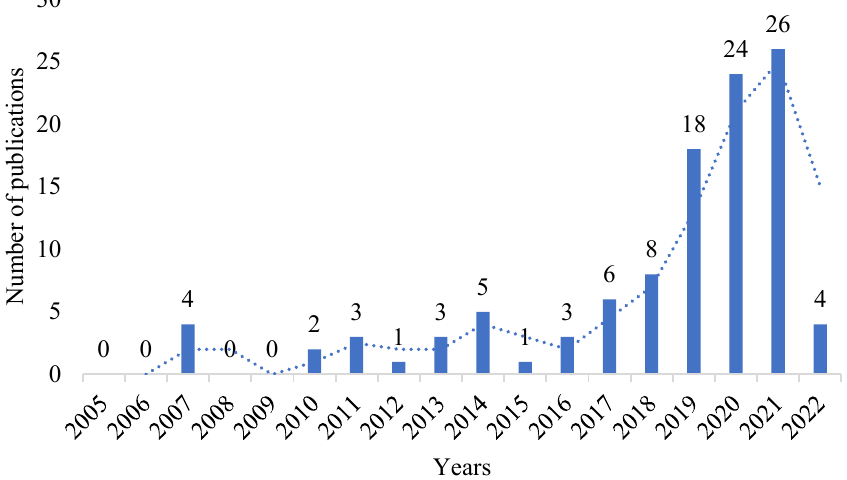
Figure 2. Evolution of research publications on compost barn from 2007 to 2022/April.